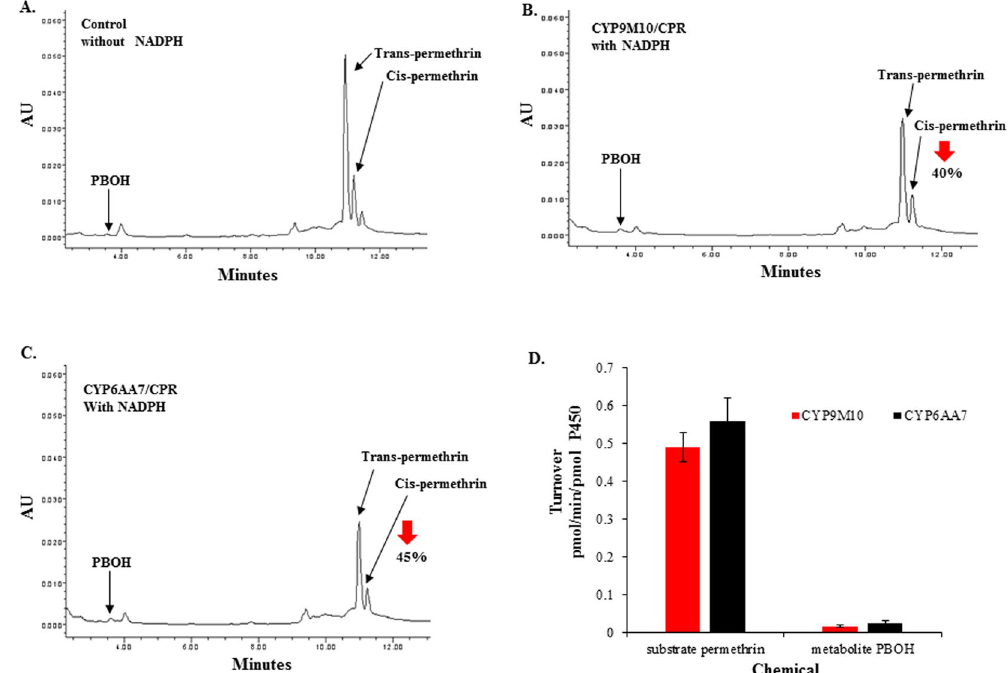
Figure 4. Permethrin metabolism by microsomes of CYP/CPR. ( A ) Control: permethrin (20 µ M) incubated with CYP9M10/CPR or CYP6AA7/CPR microsomes (100 pmol P450 in 0.1 M Tris pH = 7.5) for 2 h at 30 °C without NADPH. The black arrows indicate the peaks for PBOH, trans-permethrin, and cis-permethrin; ( B ) Permethrin metabolized by microsomes of CYP9M10/CPR expressing Sf9 cells with NADPH; ( C ) Permethrin metabolized by microsomes of CYP6AA7/CPR expressing Sf9 cells with NADPH; ( D ) Permethrin turnover rate in the CYP/CPR co-expressed microsomal protein with and without NADPH, and the rate of formation of the metabolite PBOH in microsomes of CYP9M10/CPR or CYP6AA7/CPR expressing Sf9